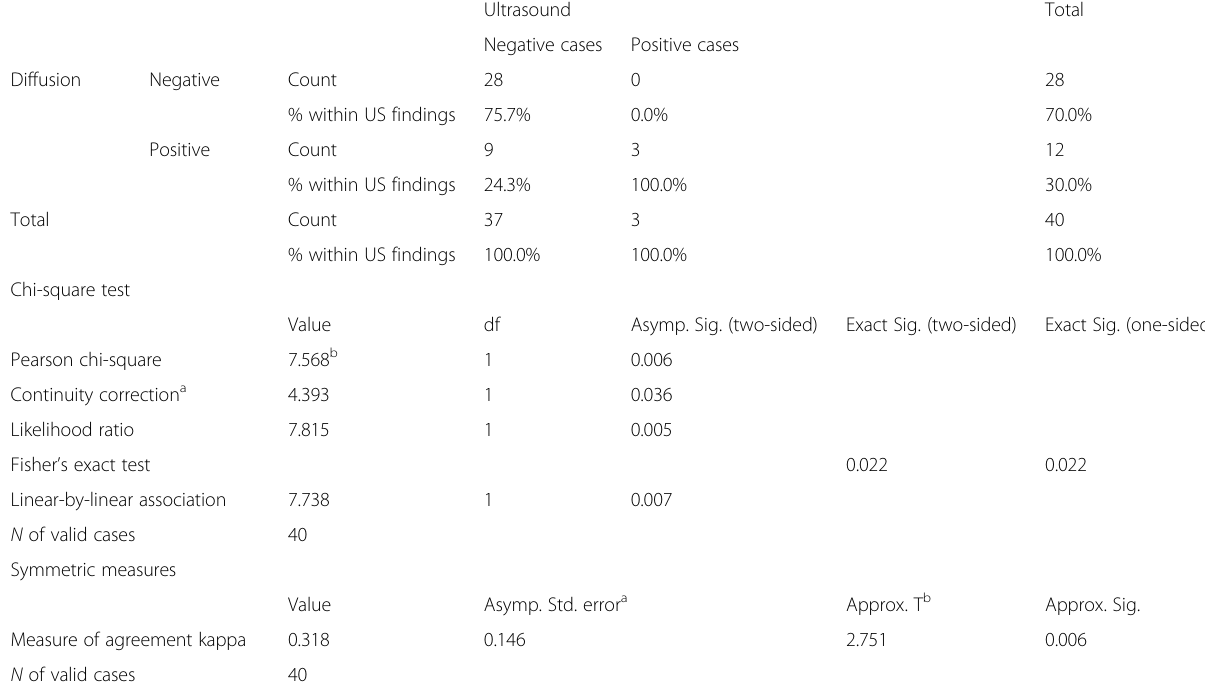
Table 4 Diffusion in correlation with ultrasound in hypertensive